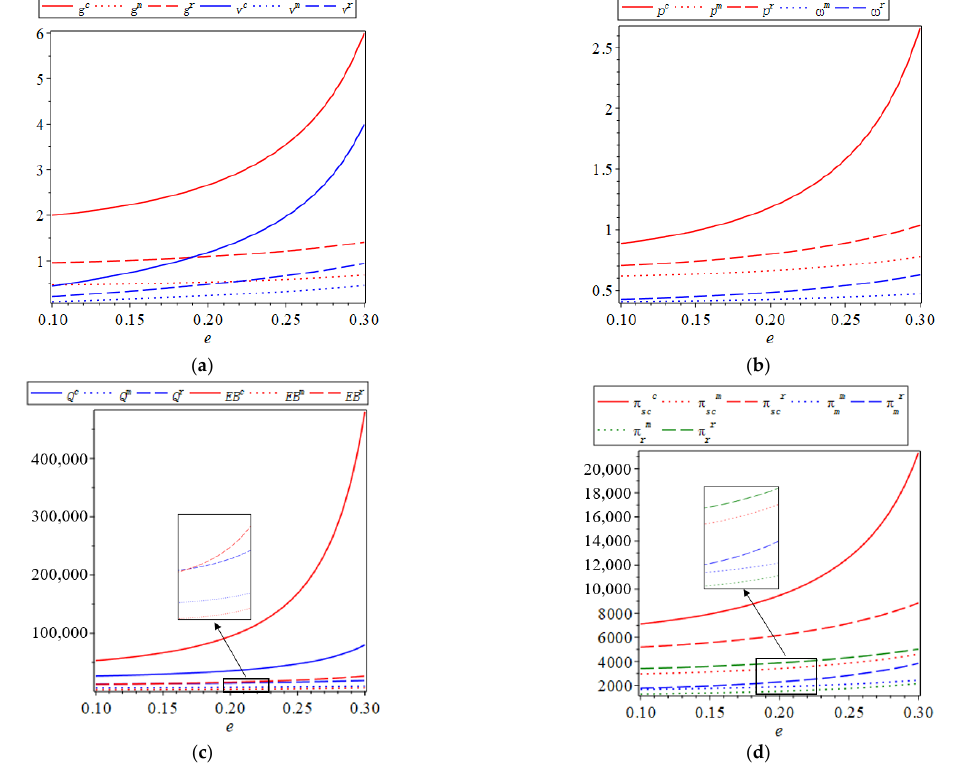
Figure 4. Decisions, demand, profits, and environmental benefit change with 𝑒 . ( a ) Greenness and targeted advertising intensity change with 𝑒 . ( b ) Prices change with 𝑒 . ( c ) Demand and environmental benefit change with 𝑒 . ( d ) Profits change with 𝑒 .